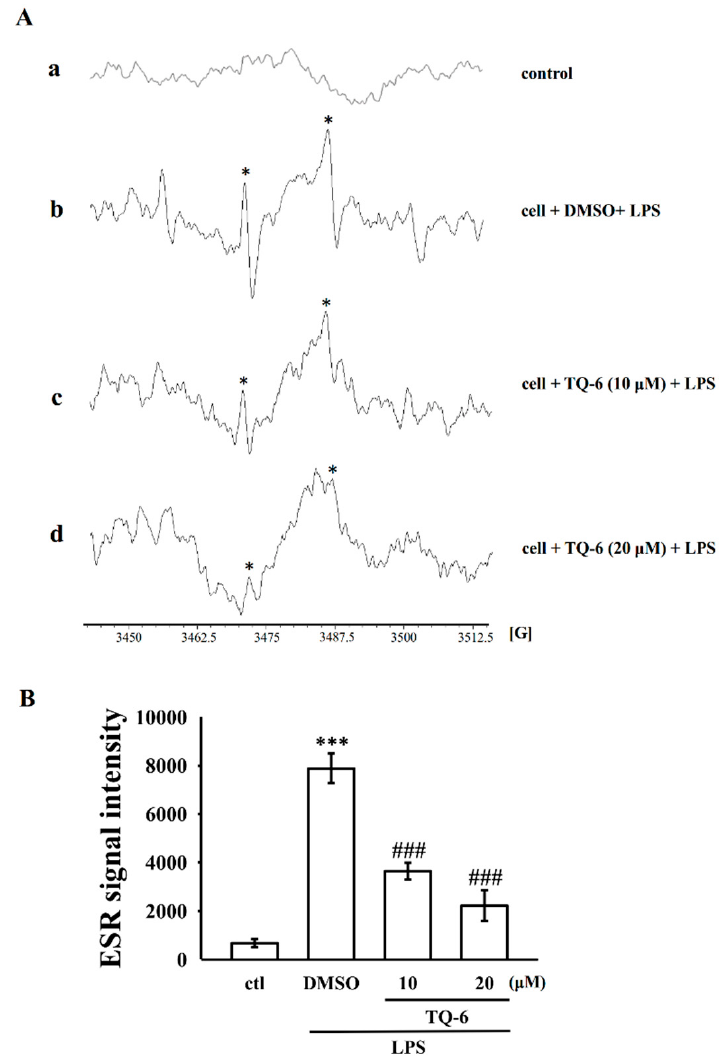
Figure 3. TQ-6 inhibits OH • formation in LPS-stimulated RAW264.7 cells. ( A ) Cells were treated with ( a ) 0.1% DMSO or ( b ) DMSO or TQ-6 at ( c ) 10 μ M or ( d ) 20 μ M and then LPS (1 μ g/mL) added